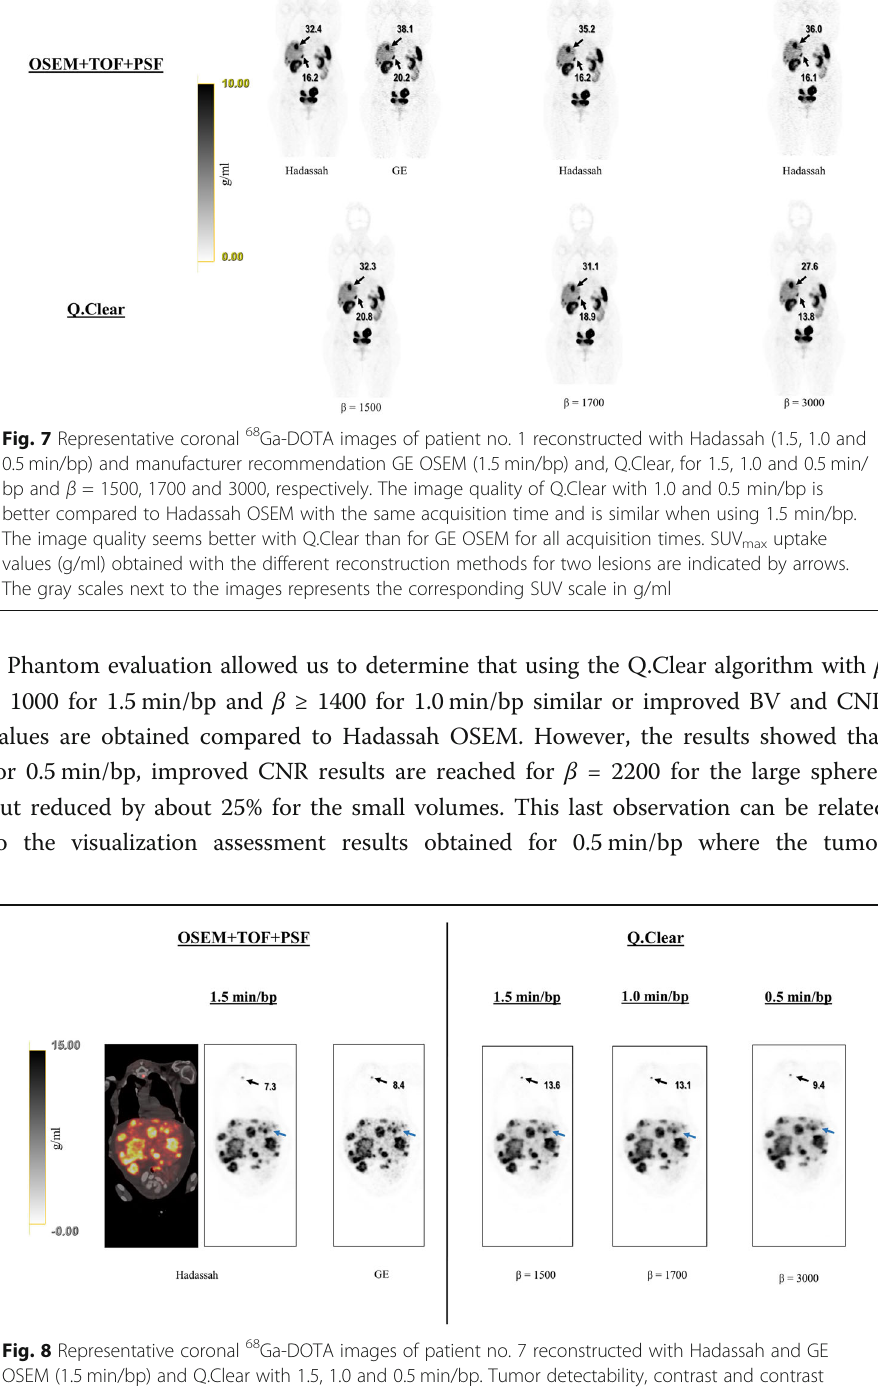
Fig. 8 Representative coronal 68 Ga-DOTA images of patient no. 7 reconstructed with Hadassah and GE OSEM (1.5 min/bp) and Q.Clear with 1.5, 1.0 and 0.5 min/bp. Tumor detectability, contrast and contrast using Q.Clear 1.5 min/bp ( β = 1500) and 1.0 min/bp ( β = 1700) was better than those using OSEM with 1.5 min/bp, but in using Q.Clear with 0.5 min/bp ( β = 3000) some lesions were missed (blue arrow for instance). Sternum lesion SUV max uptake value (g/ml) obtained with the different reconstruction methods is indicated by black arrows. The gray scale next to the images represents the corresponding SUV scale in